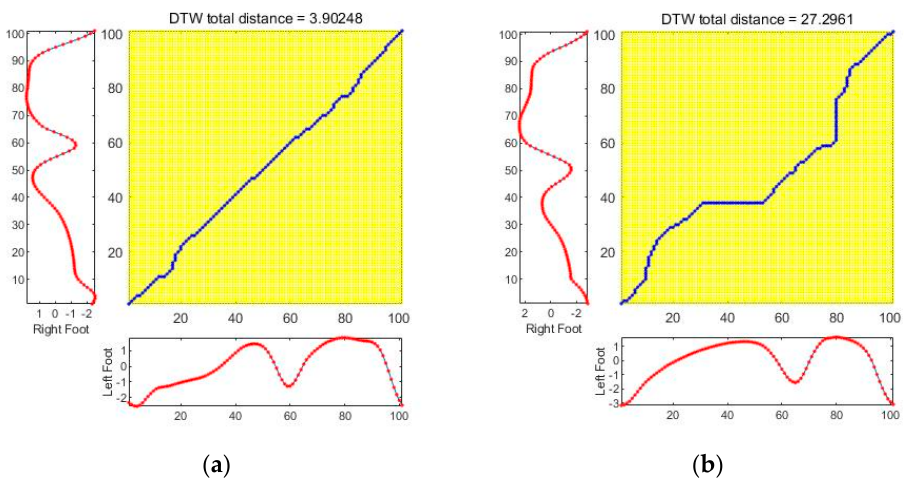
Figure 12. The results of DTW. ( a ) Symmetric gait; ( b ) asymmetric gait.